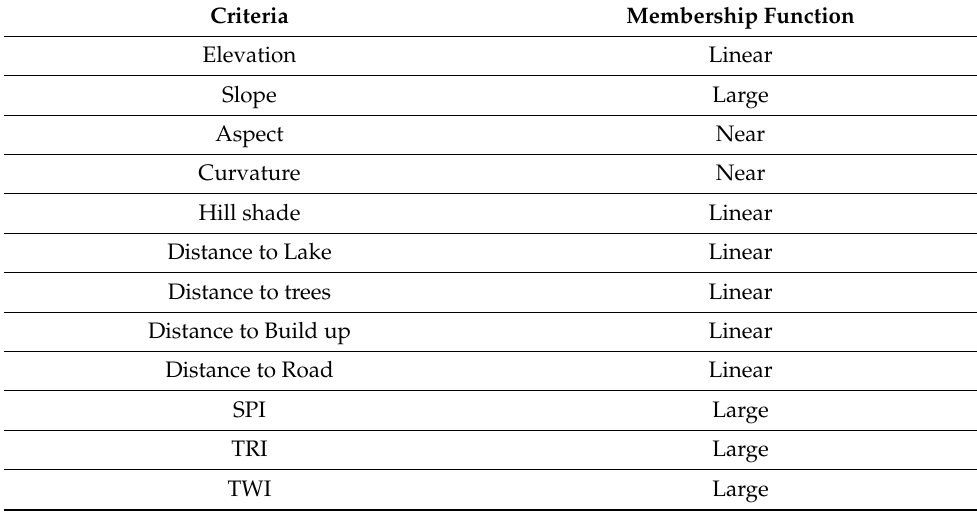
Table 3. The fuzzification conditioning